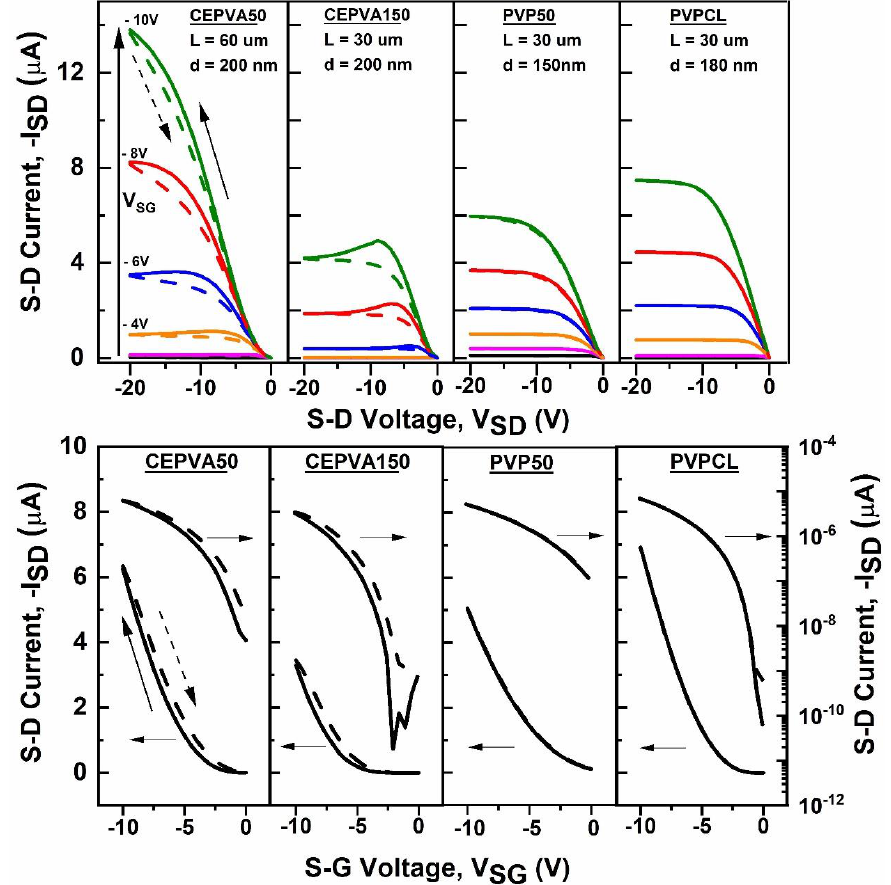
Figure 3. Output (top panel) and transfer (bottom panel, V SD = − 10 V) I–V characteristics of OFETs with different gate dielectrics. Measurement directions: solid line — increasing applied voltage and dash line — decreasing voltage. Measured in high vacuum (p < 10 − 3 Pa), gate sweep rate 1 s per full cycle.